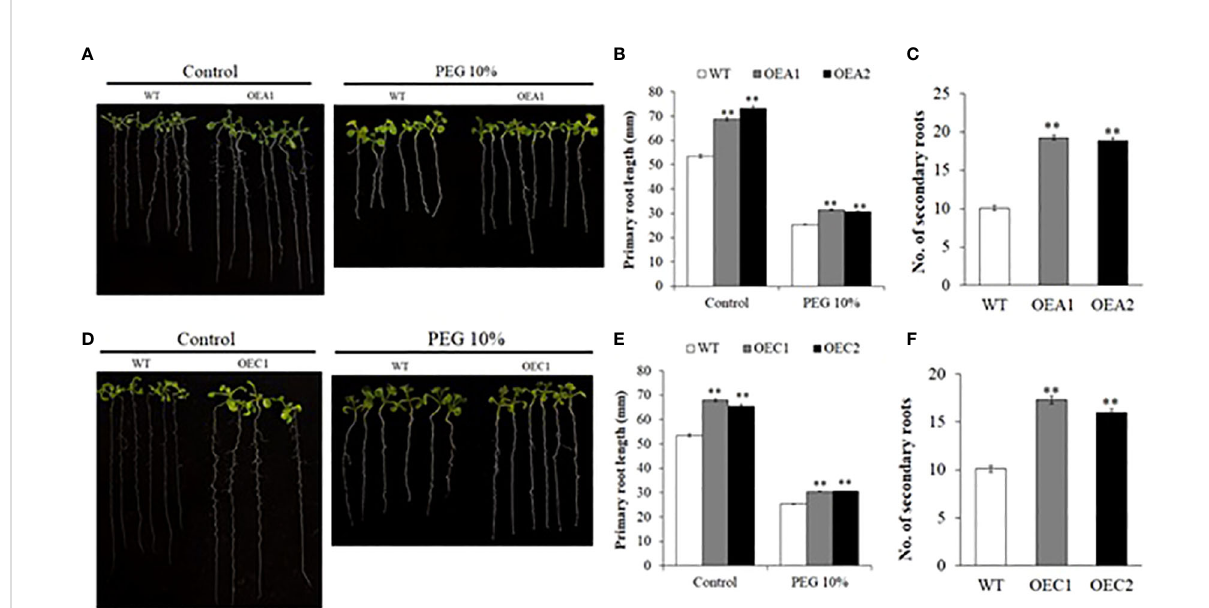
FIGURE 6 Root growth in HD2-OE lines under control and osmotic stress. Images of root growth in 10-day old WT, HD2A-OE (A) and HD2C-OE (D) seedlings under control and PEG-6000 (10%) conditions. (B, E) Primary root lengths measured in 10-day old WT, HD2A-OE (B) and HD2C- OE (E) seedlings under control and PEG (10%). (C, F) Secondary root number counted in 10- day old seedlings of WT, HD2A-OE (C) and HD2C- OE (F) seedlings under control conditions. Data shown are means ± standard errors (n = 60). Three independent experiments were performed in this test. In each experiment, 20 seedlings of each genotype were used to measure the primary root lengths. The signi fi cance of the differences between different genotypes was determined by Student ’ s t test (**p < 0.01).